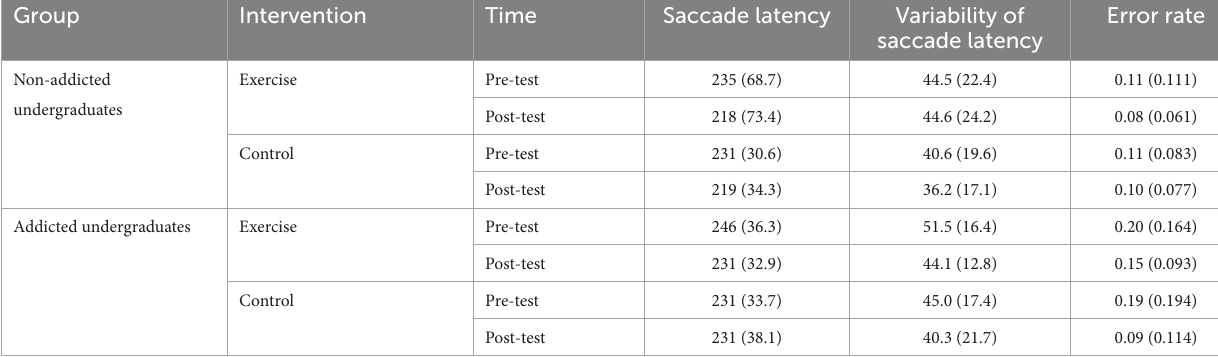
TABLE 1 Mean and standard deviation of eye movement measures in antisaccade task for all groups of participants.